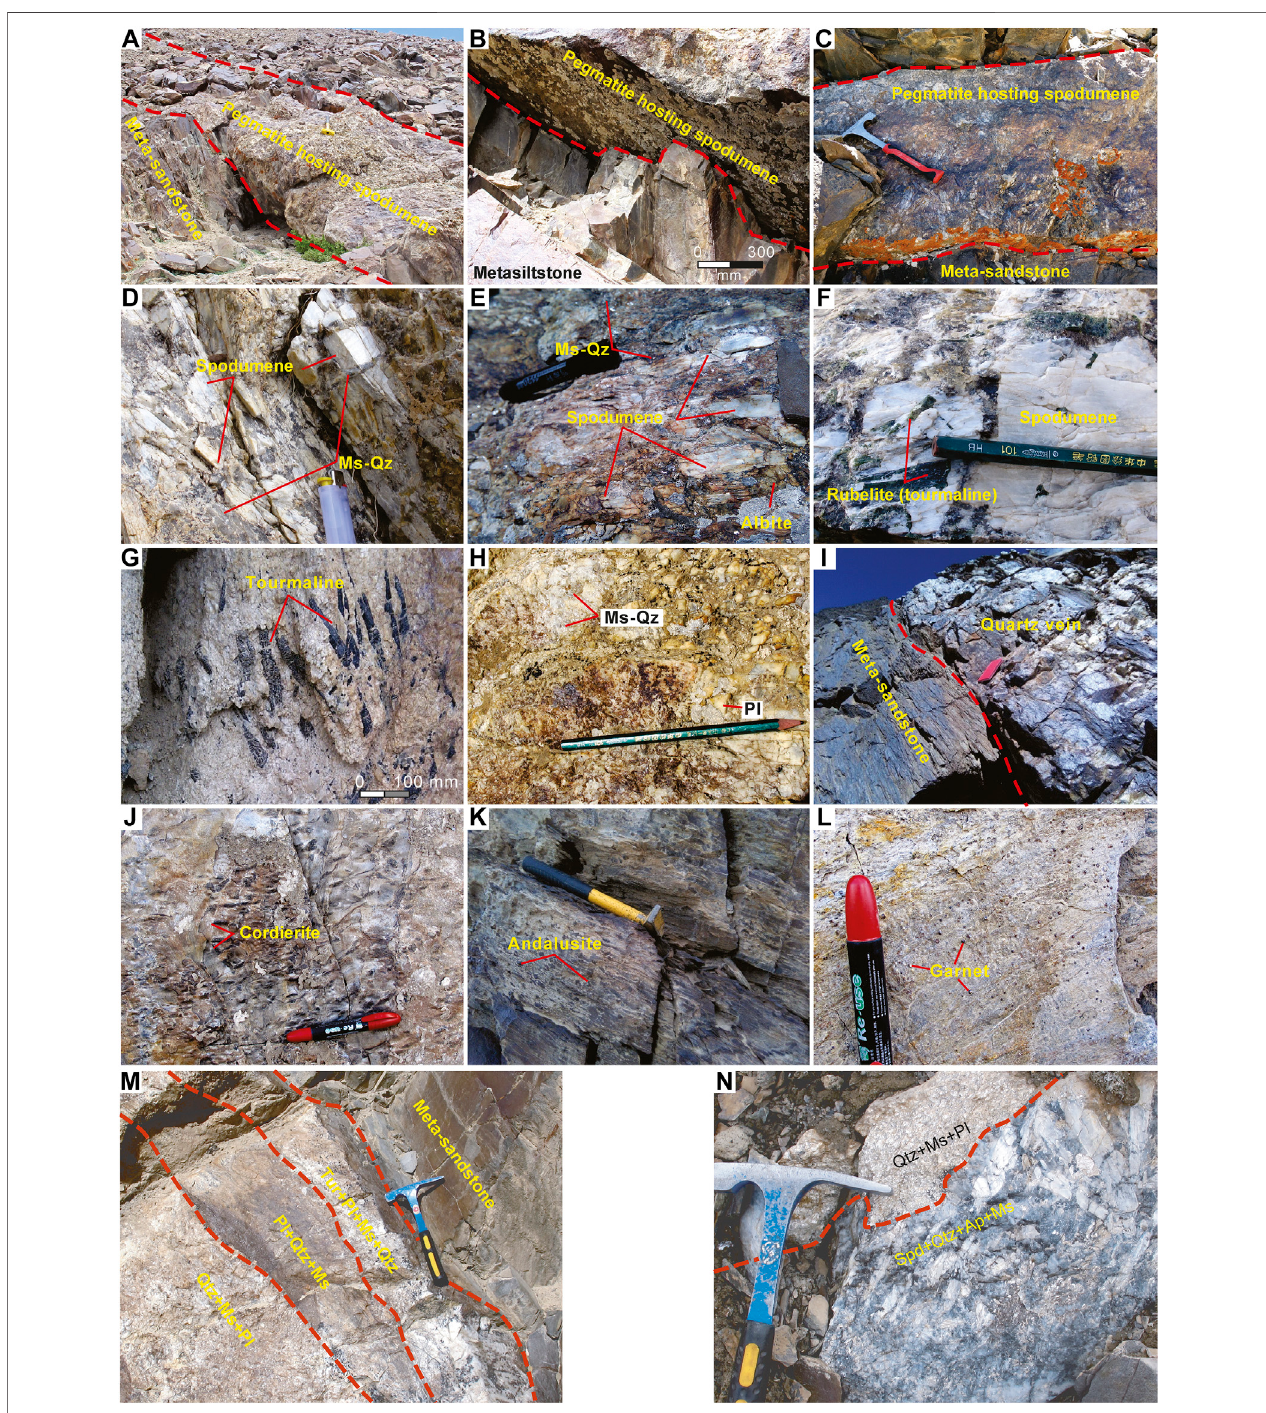
FIGURE 10 | Photographs of rocks in the Dahongliutan area: (A) spodumene-bearing pegmatite intruding meta-sandstone in the Bayankala Formation; (B) spodumene-bearingpegmatitesubparalleltolayeringinthehostrocks; (C) anexampleofspodumene-bearingpegmatitecross-cuttinglayeringinthecountryrocks; (D) long,greytowhitespodumenecrystalsintergrownwithmuscoviteandquartzhostedbyafault; (E) pegmatiteconsistingofmuscovite,albite,quartz,andspodumene; (F) green rubellite (tourmaline) coexisting with spodumene in pegmatite; (G) tourmaline-bearing pegmatite consisting of black tourmaline, plagioclase, muscoviteand quartz; (H) non-mineralised pegmatite consisting of plagioclase, muscovite and quartz; (I) an example of quartz veining in meta-sandstone; (J) hornfelsed greysiltstone containing cordierite; (K) dark grey andalusite in hornfelsed siltstone; and (L) garnet-bearing hornfelsed siltstone located near a spodumene-bearing pegmatite.Zoned pegmatite dykes in the Dahongliutan area containing: (M) black tourmaline-plagioclase-muscovite-quartz, plagioclase-quartz-muscovite, and quartz- muscoviteplagioclase; and (N) quartz-muscovite-plagioclase, and spodumene-quartz-albite-muscovite. Abbreviations: Spd, spodumene; Qtz, quartz; Ms, muscovite; Pl, plagioclase; Ab, albite; Tur, tourmaline.